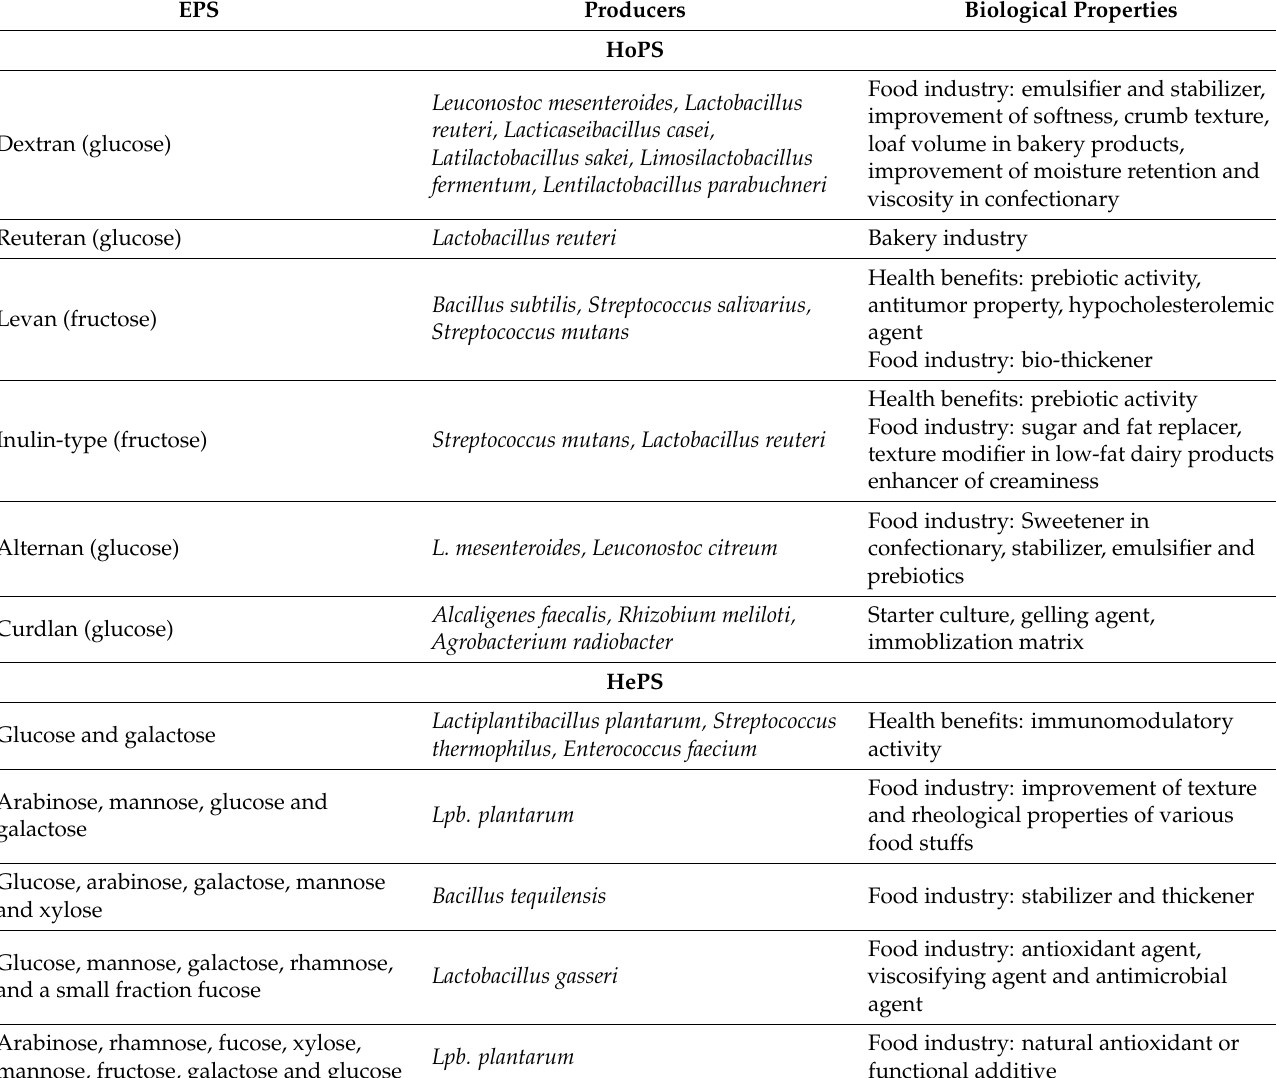
Table 1. Industrial applications and health properties of some HoPS and